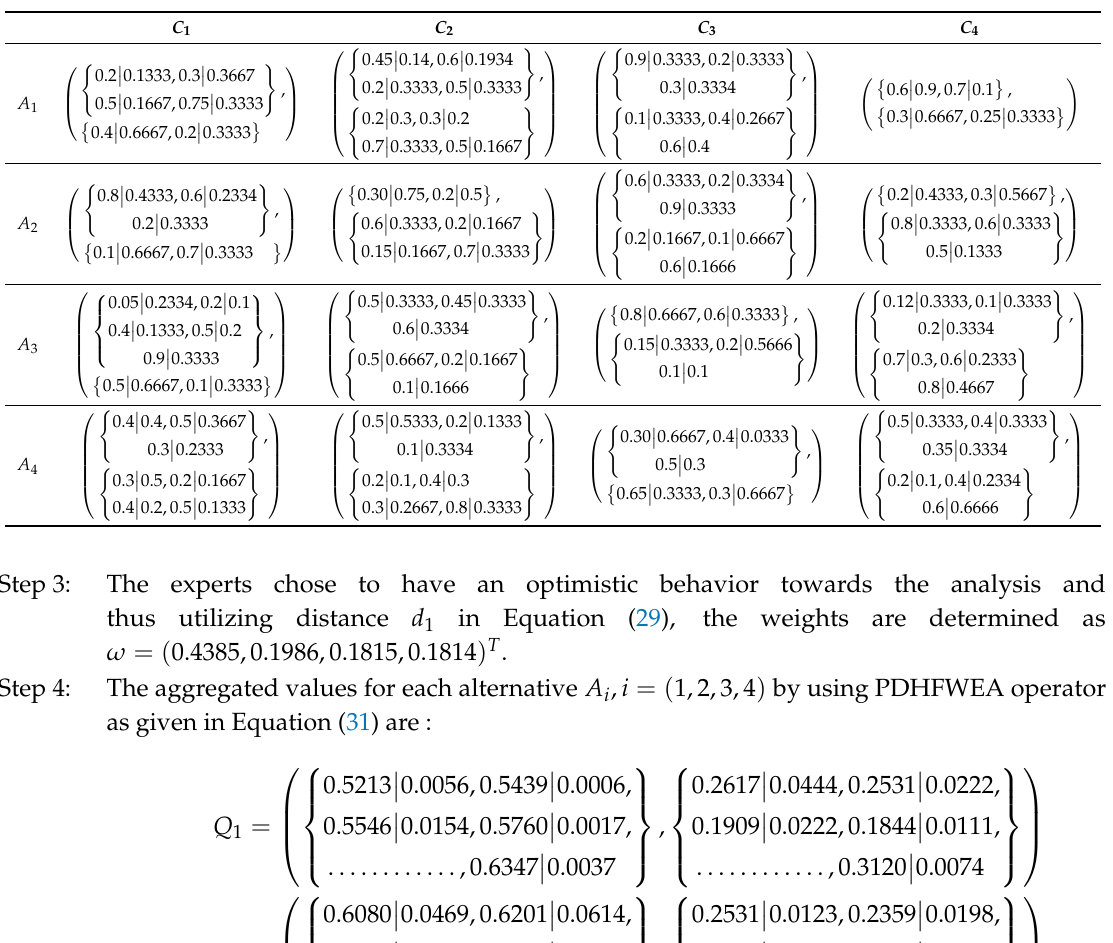
Table 4. Comprehensive matrix.